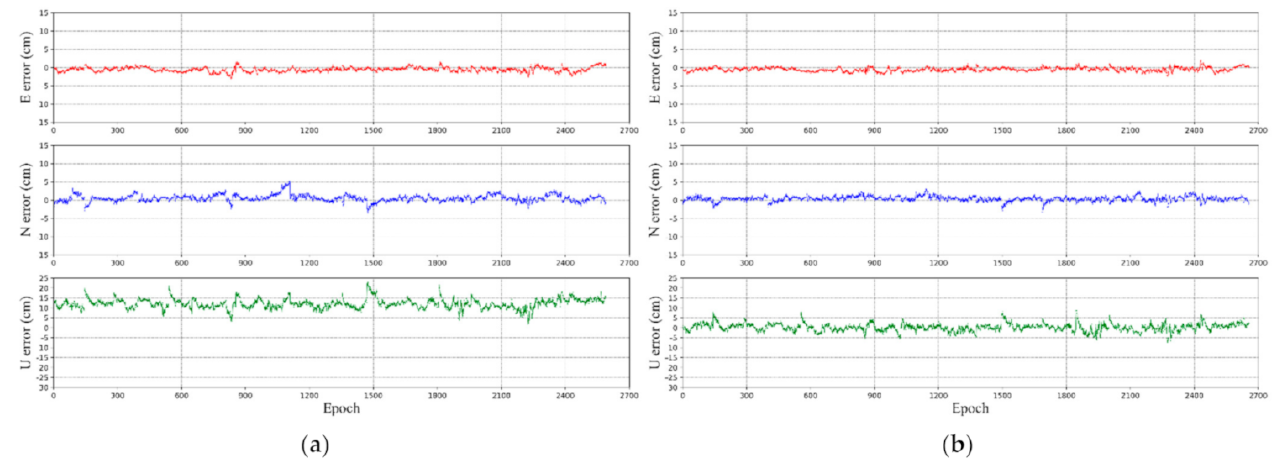
Figure 16. The TLIM ( a ) and MLIM ( b ) positioning errors with respect to the epoch during the selected data period at rover